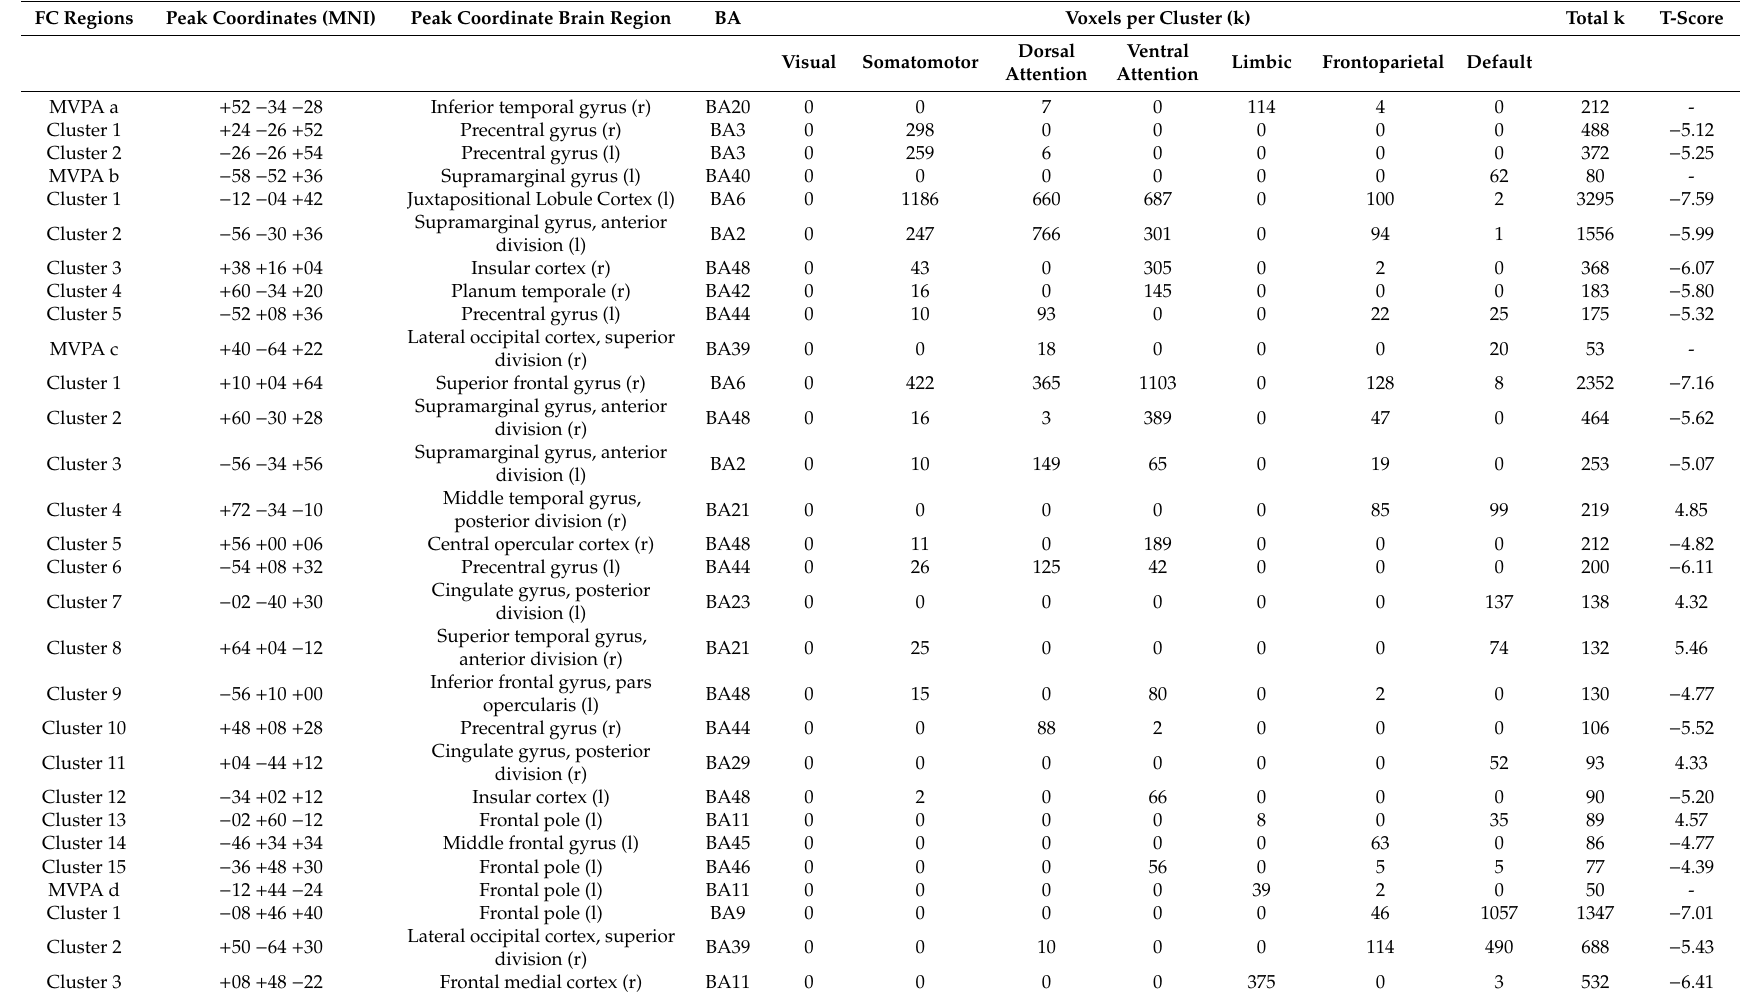
Table 2. Reading composite functional